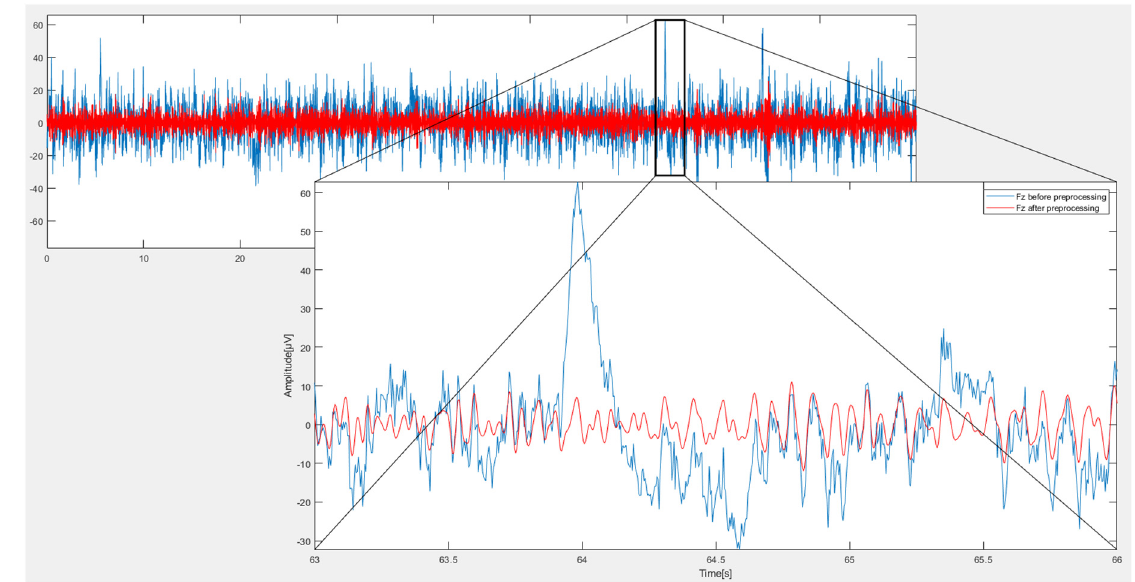
Figure 5. Fz channel before and after using preprocessing stage. Sensors 2023 , 23 , x FOR PEER REVIEW